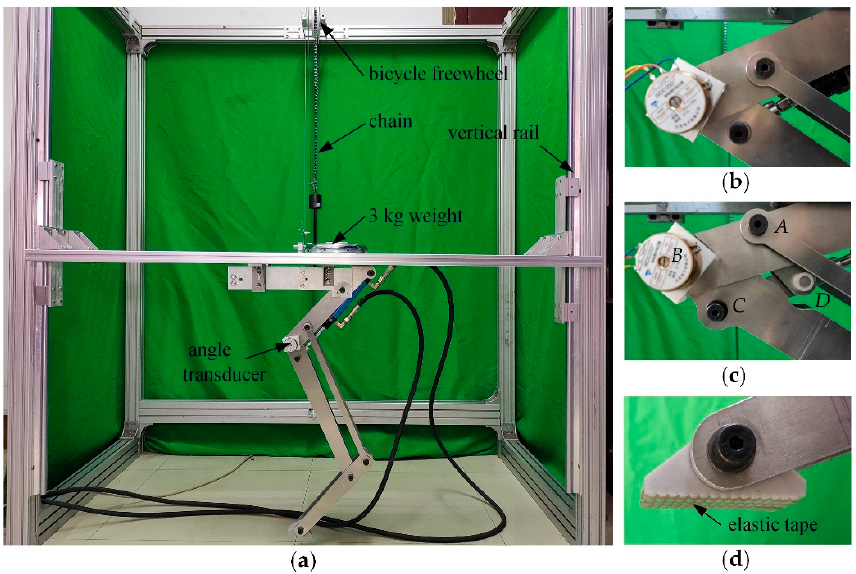
Figure 4. One-legged vertical hopping robot platform. ( a ) Prototype of the one-legged robot and the test platform; ( b ) Close-up view of the DAG; ( c ) Close-up view of the FMAG; ( d ) Close-up view of the toe.